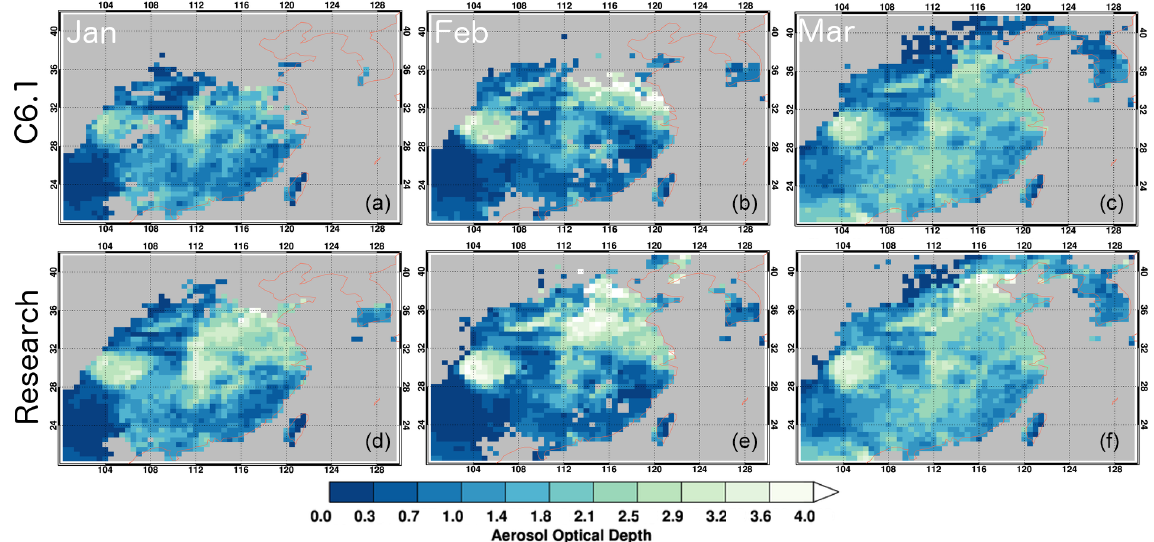
Figure 13. Spatial distribution of averaged AOD from the operational product (a–c) and the research product (d–f) at 0.5 ◦ resolution over the study domain from January to March 2013.